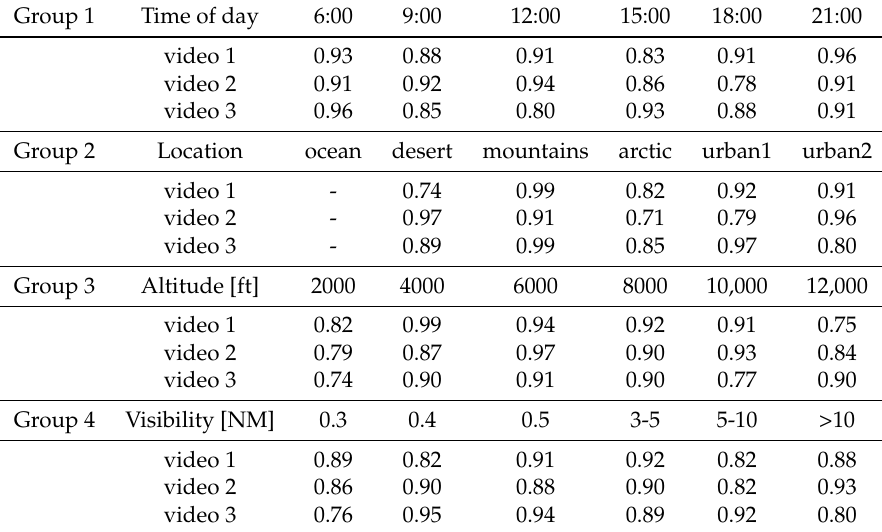
Table 4. The results (Jaccard indices) for X-Plane videos.